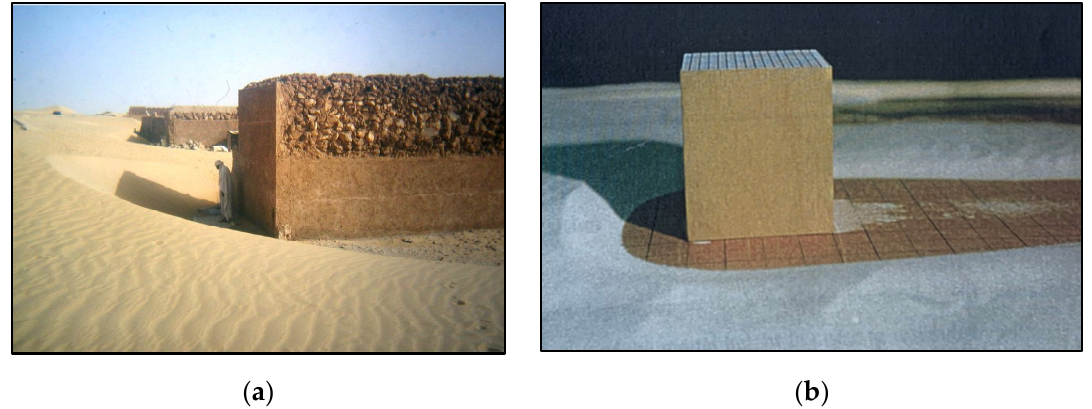
Figure 12. Echo dune developing around a cubic building ( a ) in the field and ( b ) simulated in the wind tunnel. (photos: M. Sherzad).